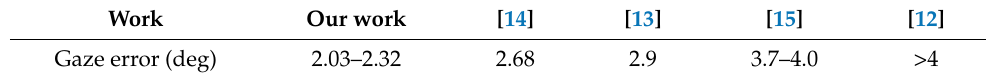
Table 4. Summary of comparison with state-of-the-art methods.